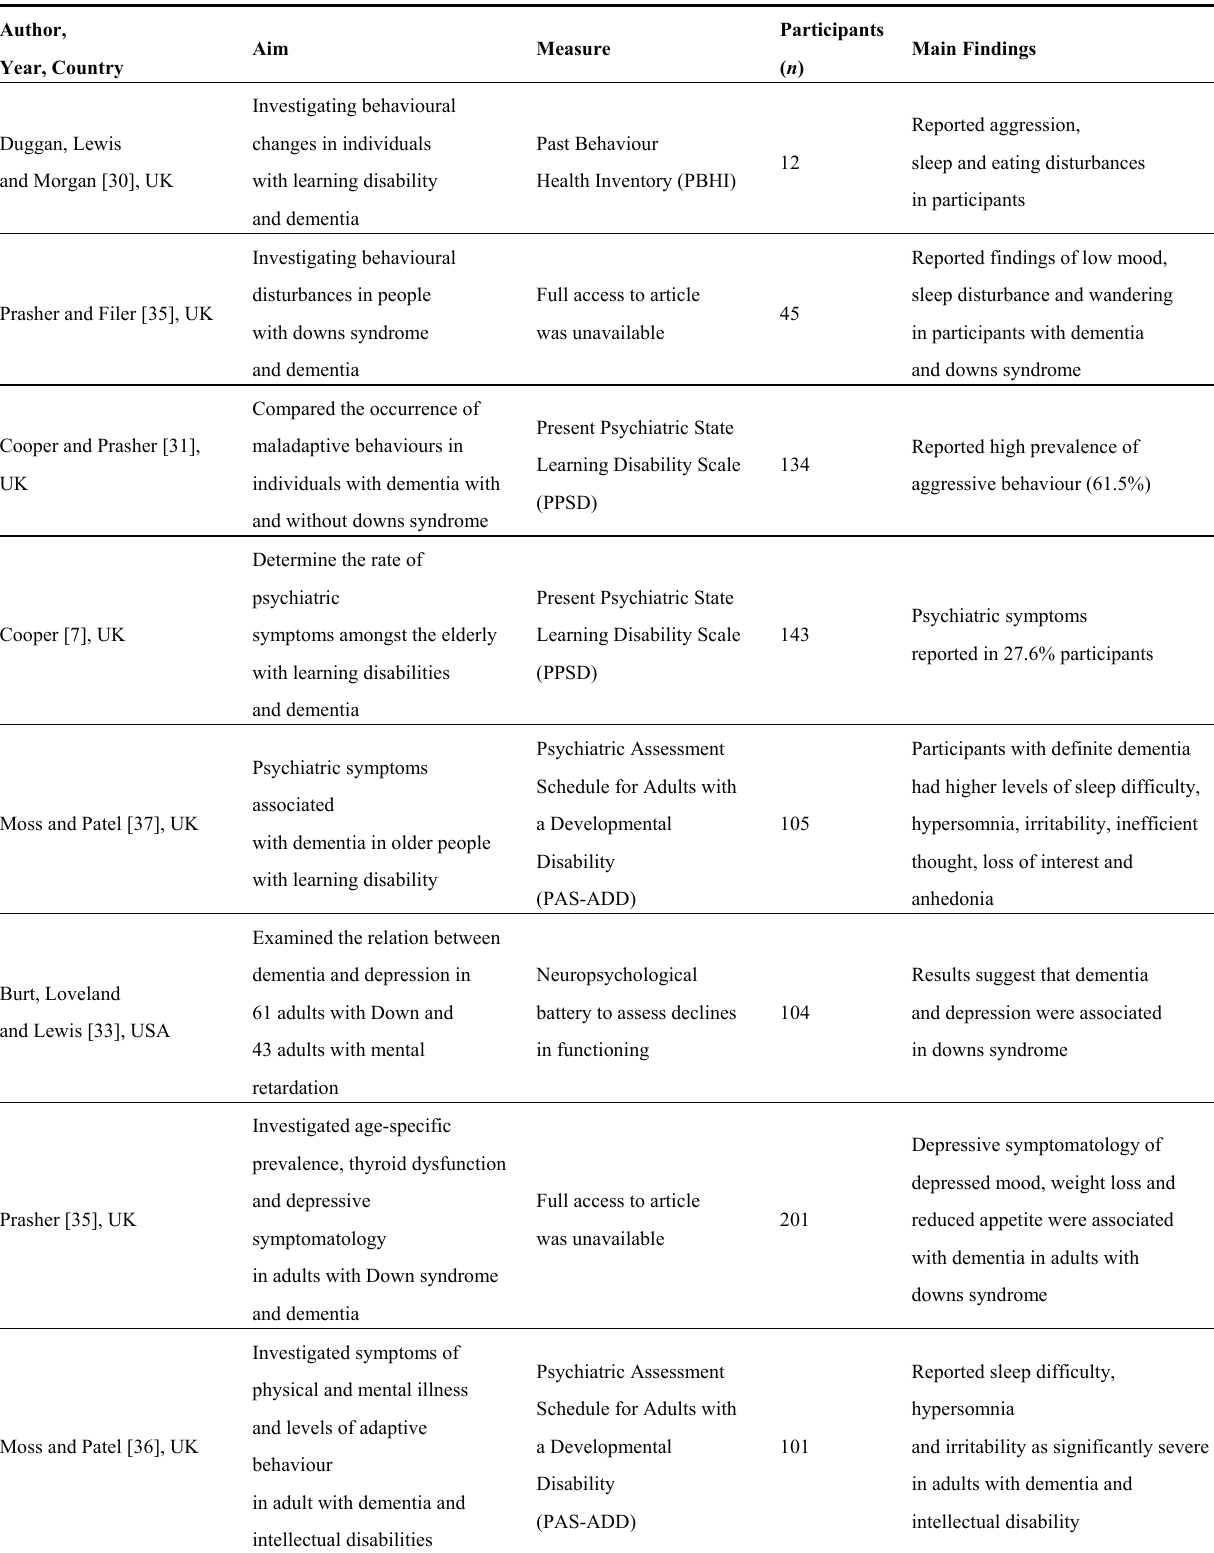
Table 2. Studies investigating behavioural and/or psychiatric symptoms within individuals with learning disabilities and